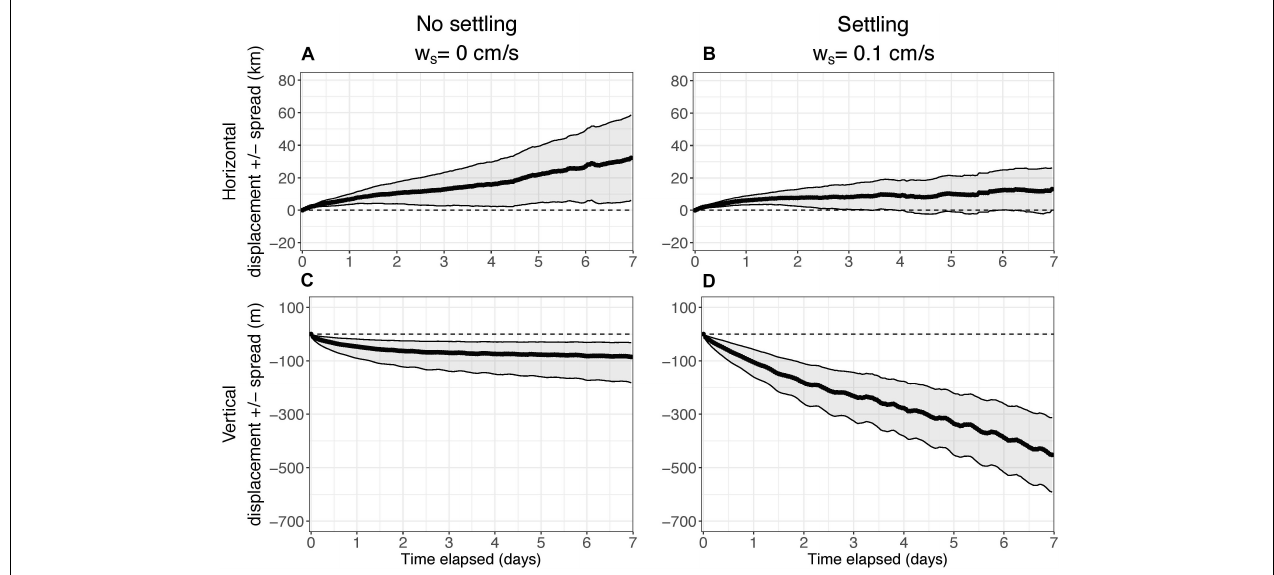
FIGURE 4 | Median horizontal displacement (km) and vertical displacement (m) of the center of mass (COM) of particles as a function of time elapsed over the 7-day simulations for k = 0 h − 1 (no decay). (A,C) show results without settling ( w s = 0 cm s − 1 ). (B,D) show results with settling ( w s = 0.1 cm s − 1 ). The edges of the shading represent the median spread (km for horizontal, m for vertical) of particles around the COM. The horizontal spread is symmetric. The vertical spread was slightly skewed, so it was calculated separately for positive and negative directions.